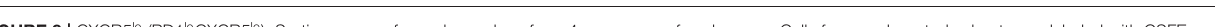
FIGURE 8 | CXCR5 lo (PD1 lo CXCR5 lo ). Sorting was performed on spleen from 4 macaques of each group. Cells from each sorted subset were labeled with CSFE prior to culture with medium or CD3/2/28 stimulatory beads. On day 5, cell proliferation (B) and viability (C) were compared between groups. (D) Concentrations of IL21 and IFN γ in cell-free culture supernatants are shown. (E) Intracellular expression of IFN γ in spleen cells. Graph shows cumulative data obtained on 7 Placebo and 5 Treated animals. Each dot corresponds to one macaque of Placebo ( open circle ) and Treated ( black circle ) group. Bars represent mean ± SEM. (F) Concentrations of CXCL13, IL17A and IL2 in culture supernatants were quantified by Multiplex assay. (G–I) Sorted T-cells (10 4 /well) were cultured with heterologous or autologous B-cells (10 4 /well) in the presence of SEB for 7 days before quantifying IgG production in cell-free culture supernatant. Cultures of B-cells plus SEB were used as controls. Results are shown in fold increase (FI) calculated as the ratio between IgG value in co-culture with T-cells and SEB and IgG value in culture without T-cells (B-cells plus SEB). (B–D,F–I) Mean ± SEM are shown for Placebo ( open bar) and Treated ( hatched bar) group. For all panels, statistical comparison between groups was performed using the Mann Whitney non-parametric test. Significant statistical values are indicated * p <